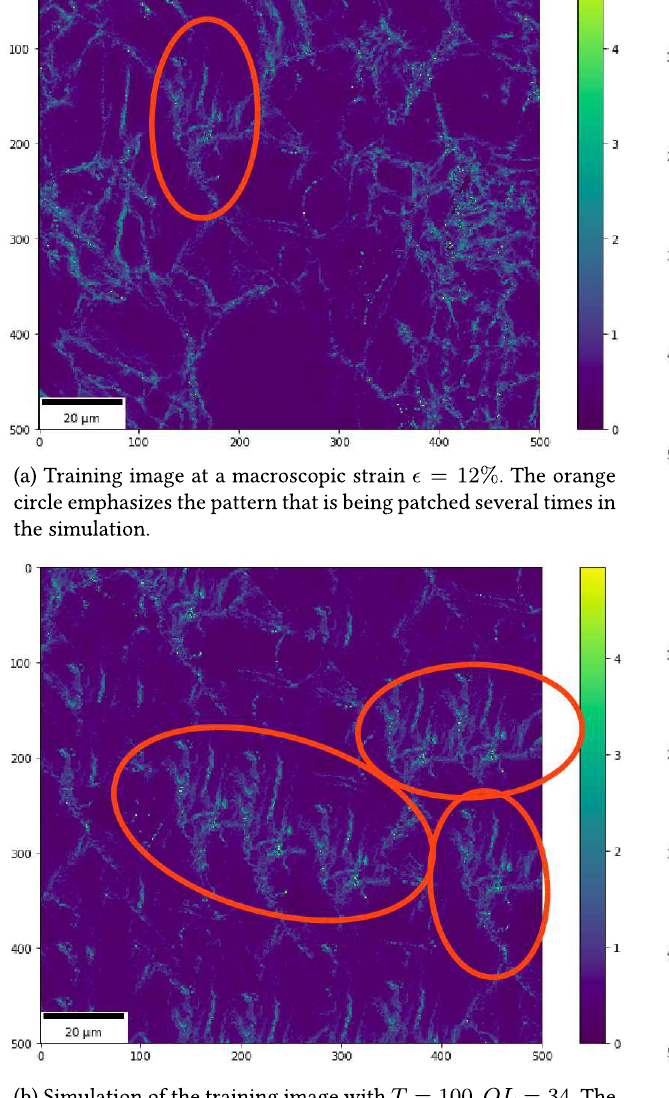
Fig. 8. Example of the issue of the repetition of patterns in the simulation – EMD = 0 . 048 .